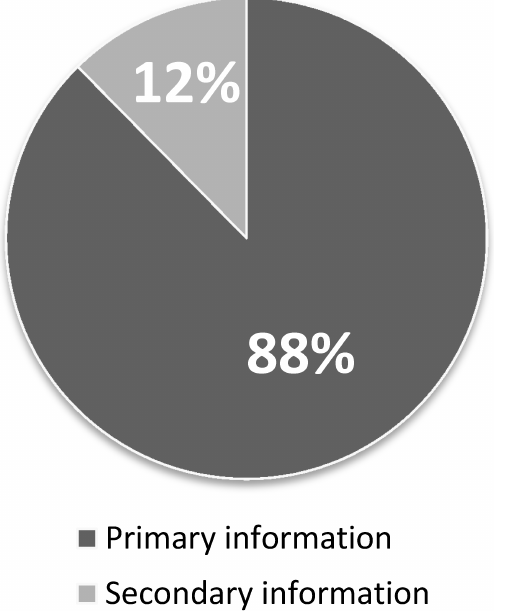
Figure 2. Ratio of primary and secondary information in Lower House election